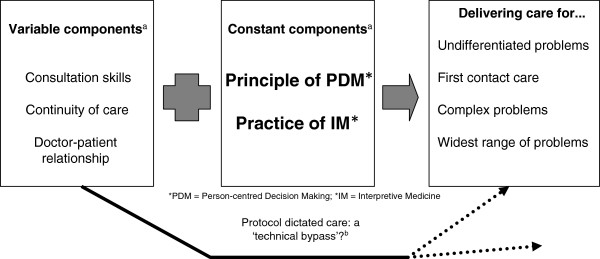
Defining expert generalist practice [[26],[27]].